Question: Condense the content of this figure into a single sentence.
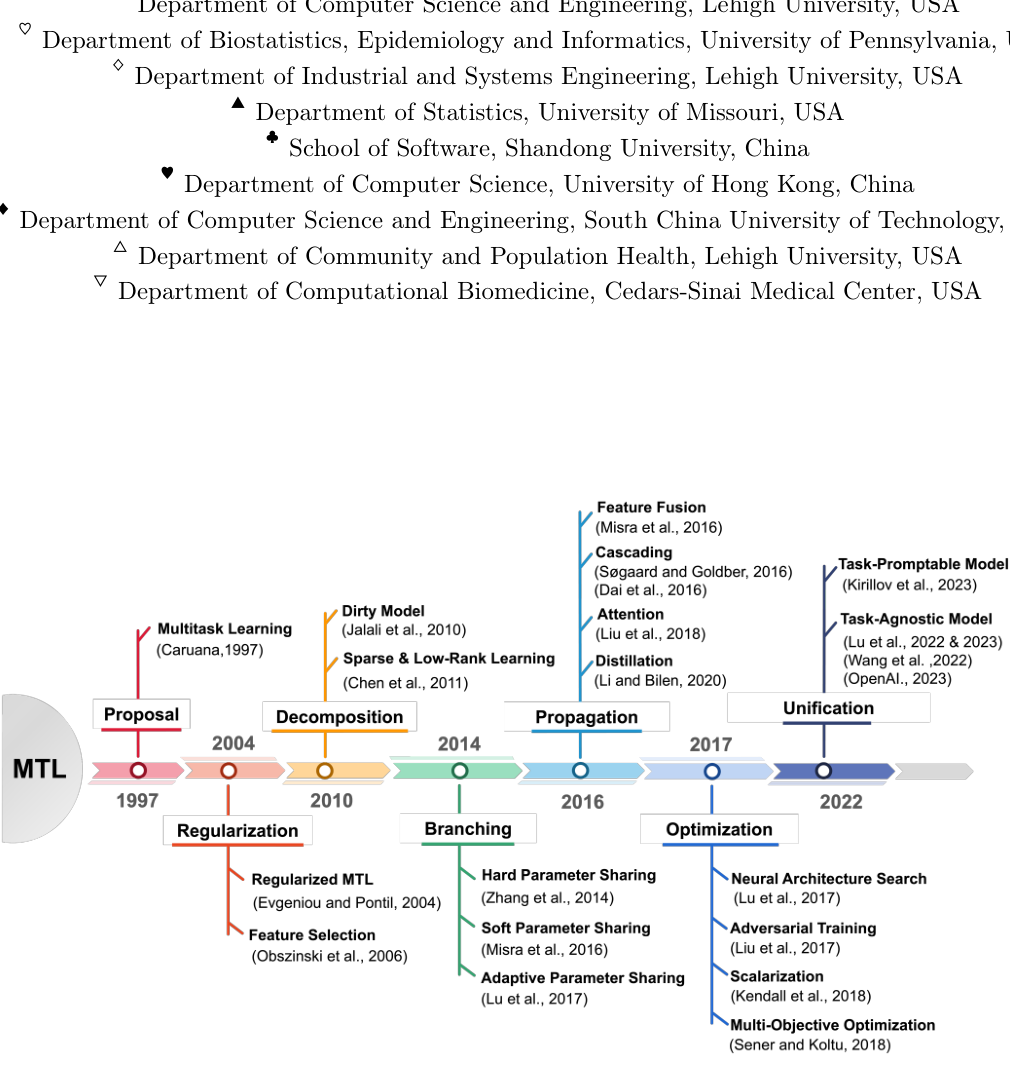
Answer: Significant landmarks in the evolution of Multi-Task Learning (MTL) highlighted over time.